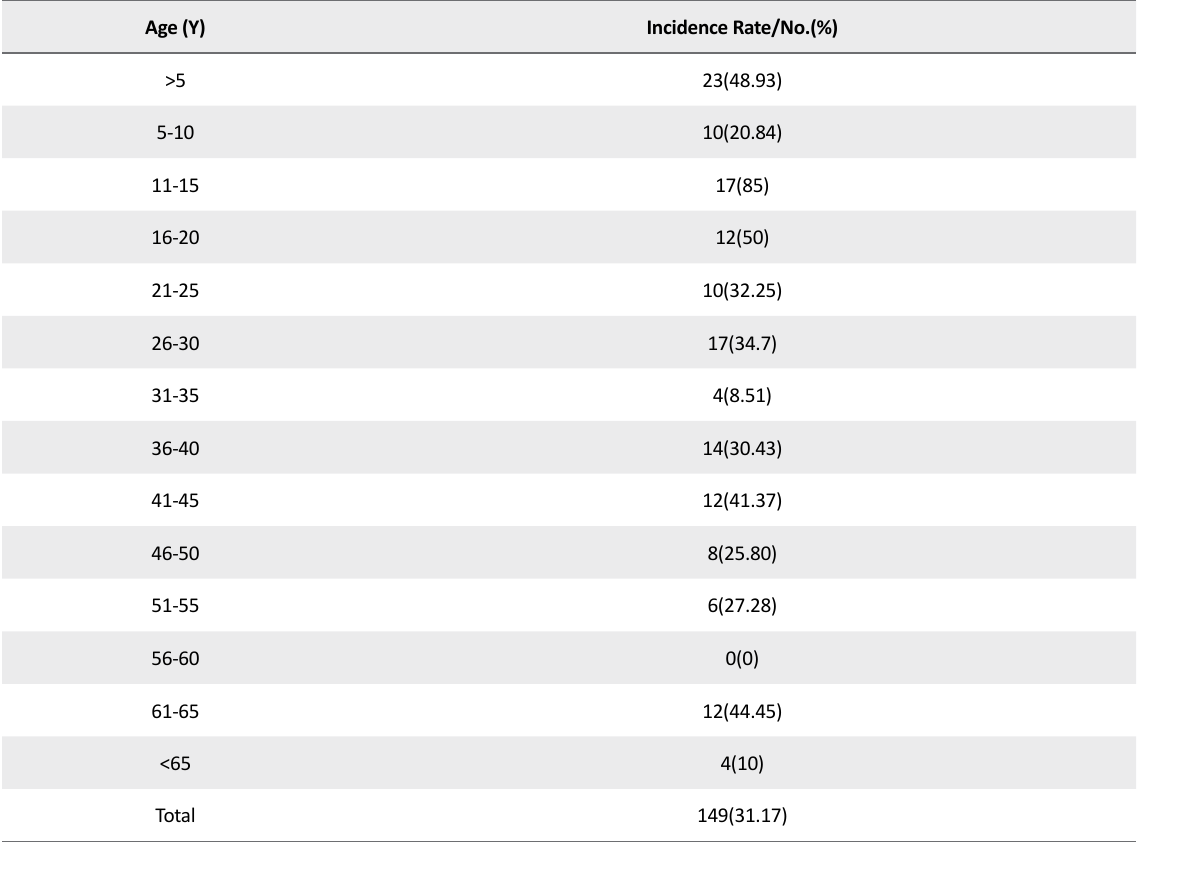
Table 2. Gastroenteritis disease incidence by age group in Kurdistan Province, Iran